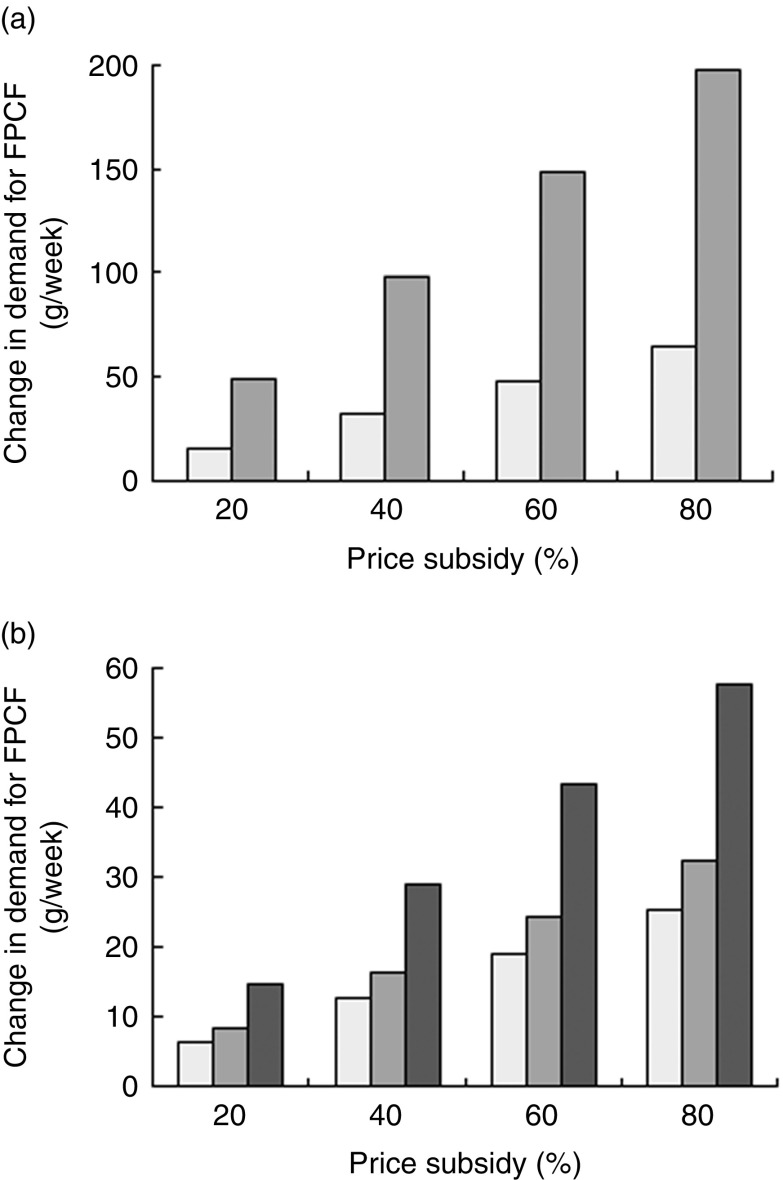
(a) Estimated demand effects and (b) weighted average demand effects of price subsidies on weekly demand for fortified packaged complementary foods (FPCF) across buyer types (
, current buyers;
, potential buyers;
, all households) in households with 6–23-month-old children from Faisalabad and Hyderabad districts, Pakistan (authors’ calculation)